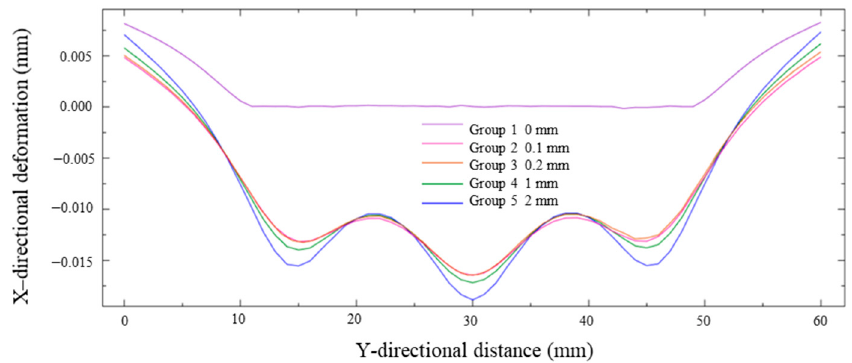
Figure 12. Observation path of the wall sheet.